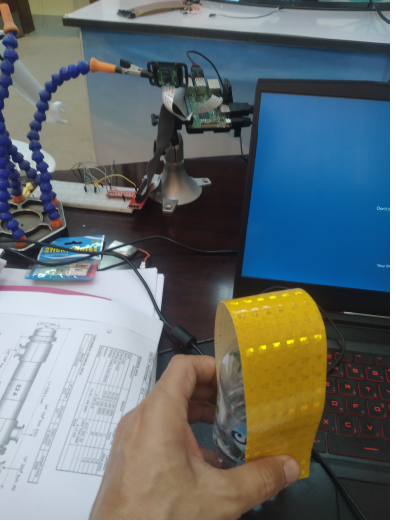
Figure 11. Photograph of tag detection (yellow